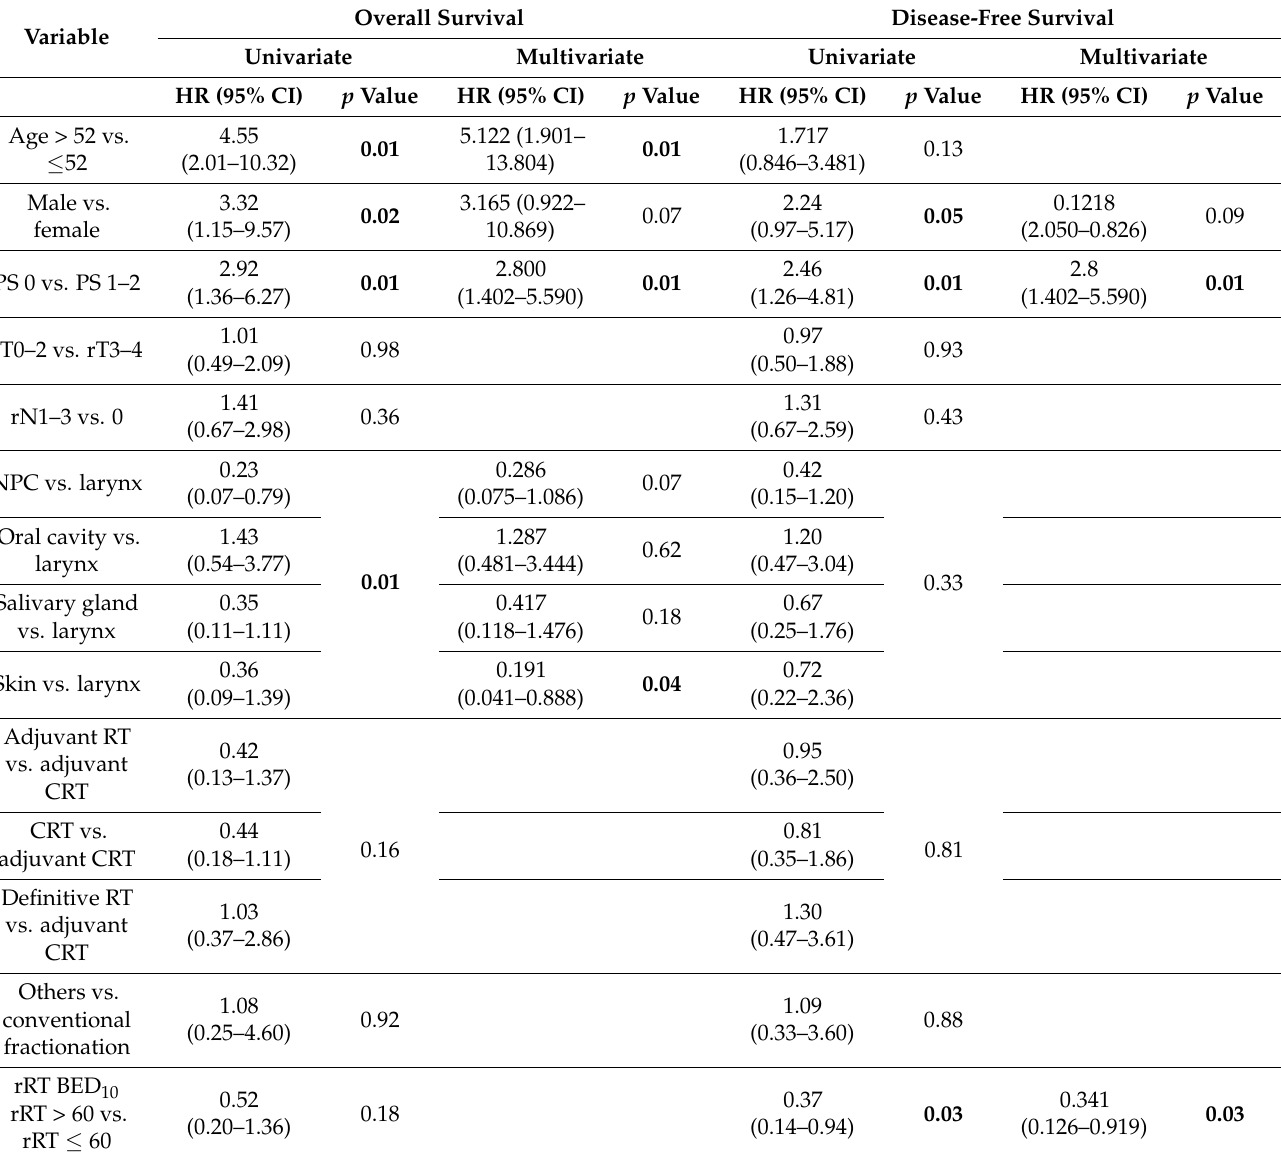
Table 4. Univariable and multivariable analyses of prognostic factors for overall survival and disease- free